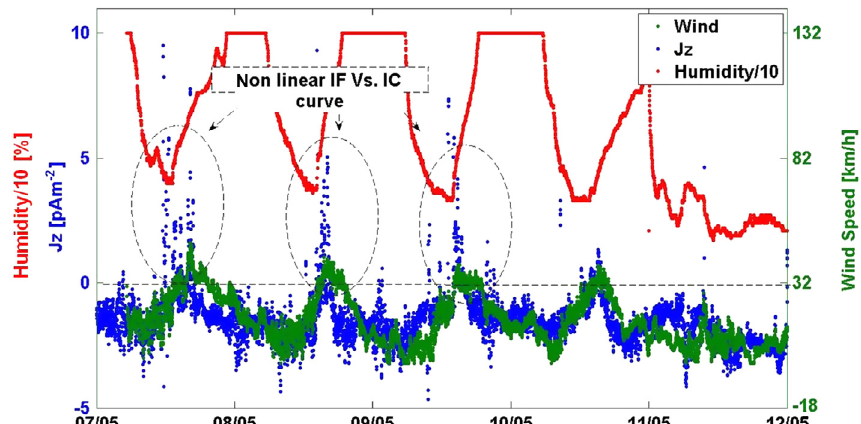
Figure 2. Aweek of data of J z values (blue points) from 7 May 2011 to 12 May 2011. Daily variations are superimposed on the changes in wind speed (green) and relative humidity (red). Dashed horizontal line indicates